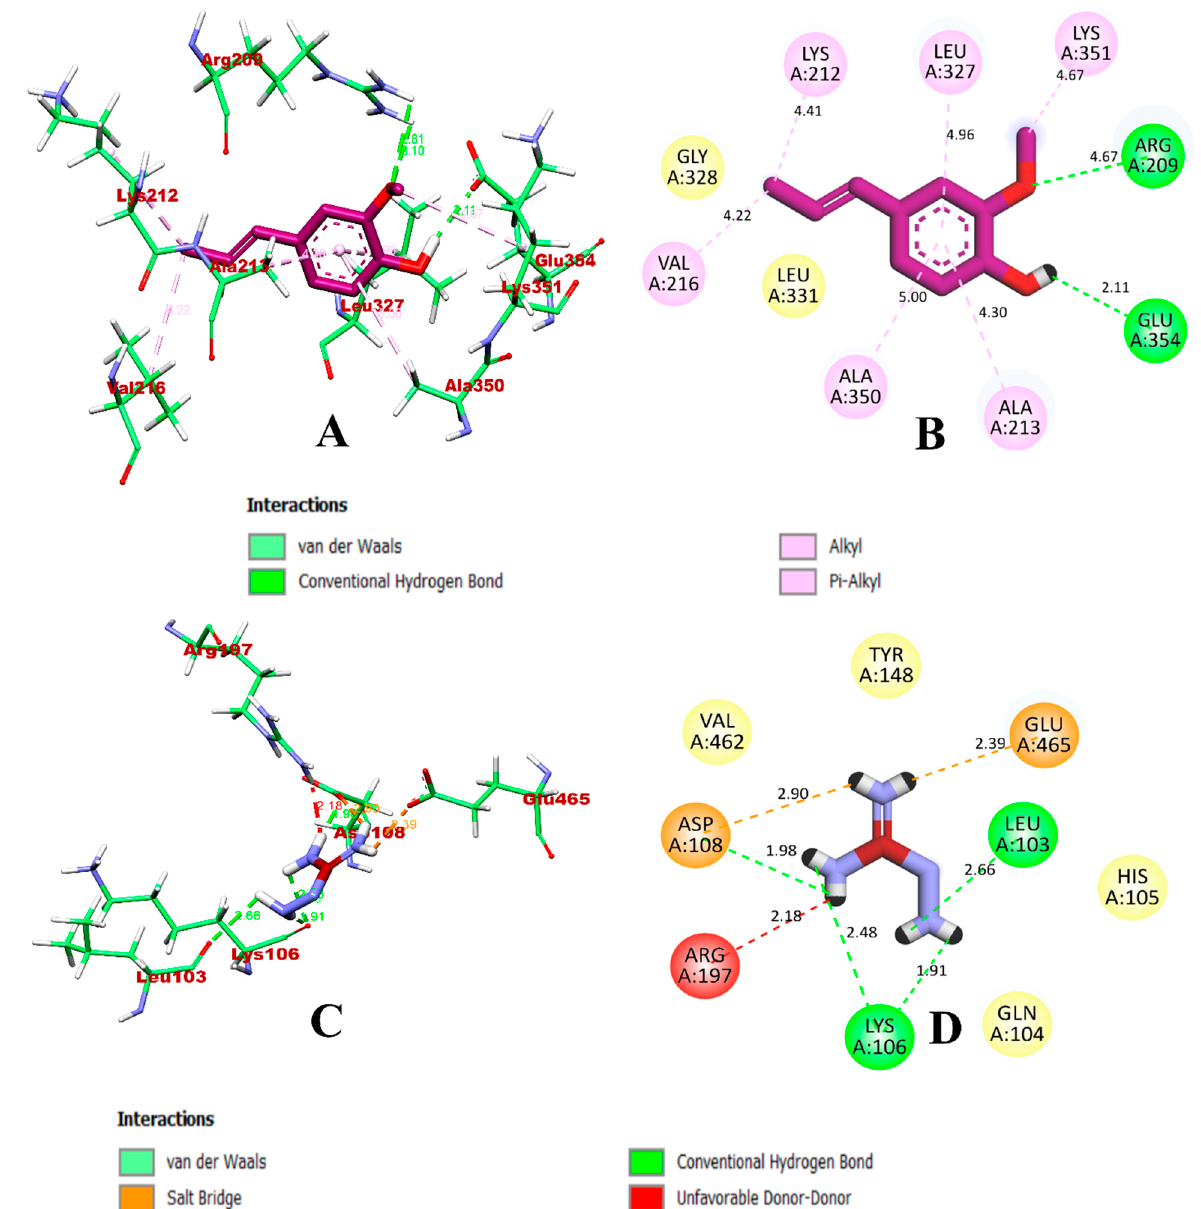
Figure 4. Visualization of the docking simulation of compounds with HSA. ( A , B ) Interaction of isoeugenol (purple) visualized in 3D and 2D, respectively. ( C , D ) Interaction of aminoguanidine (red) visualized in 3D and 2D, respectively.